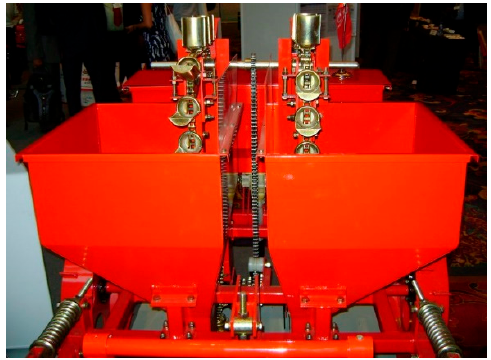
Figure 10. Menoble 3-point linkage mounted single row potato harvester for a 30 hp tractor (Photo: Brian Sims). Environments 2016 , 3 , 11